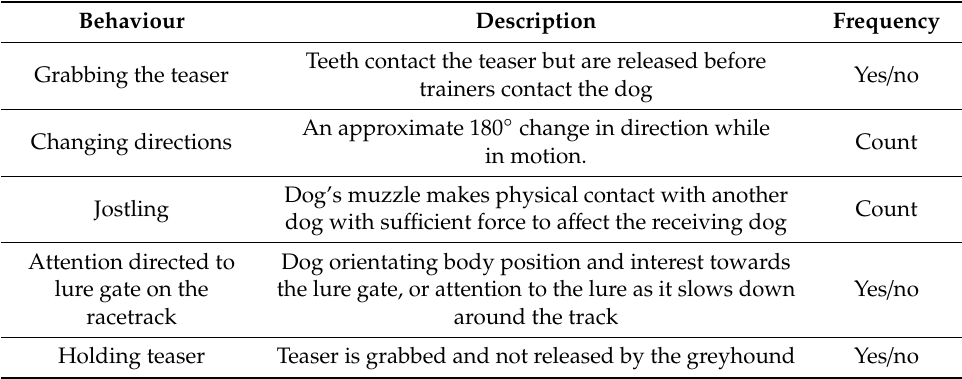
Table 2. Ethogram of all the behaviours that potentially indicate negative emotional valence in greyhounds in the catching pen after a